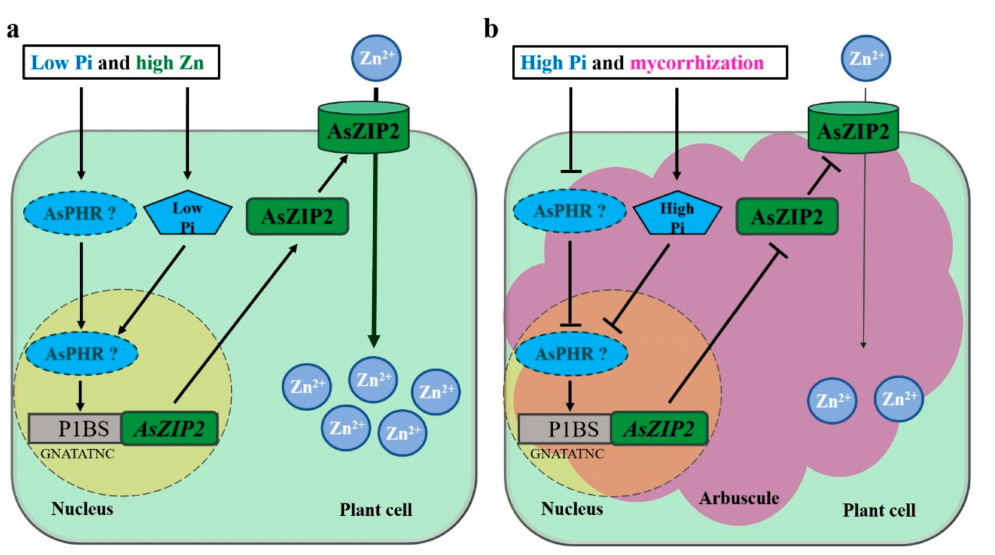
Figure 10. Proposed working model in which the AsZIP2 zinc transporter is repressed by phosphate and arbuscular mycorrhizal symbiosis in A. sinicus under moderately high Zn conditions. ( a ) Under Pi starvation, low intracellular Pi availability induces AsZIP2 expression, possibly dependent on the potential AsPHR-P1BS pathway in A. sinicus , due to the presence of P1BS (GNATATNC) motif in the promoter region of AsZIP2 (see Figure S3); meanwhile, high Zn supply results in low Pi concentration in A. sinicus (see Figure 1a), and consequently promotes the transcription of AsZIP2 to facilitate the activation of Zn transporter AsZIP2 in the plasma membrane. Both the processes lead to the over-accumulation of Zn 2+ in plant cells. ( b ) Under high Pi conditions, high Pi availability reduces AsZIP2 expression via the potentially inactivated AsPHR-P1BS module. On the other hand, arbuscular mycorrhization significantly increases cellular Pi concentration, which can also repress the AsZIP2 expression in a similar manner, leading to less Zn 2+ accumulation in A. sinicus . The solid arrows present the positive influences or interactions, whereas the flat-ended lines indicate the negative influences or interactions; the question marks indicate a non-confirmed AsPHR-P1BS module that possibly controls AsZIP2 expression in A. sinicus